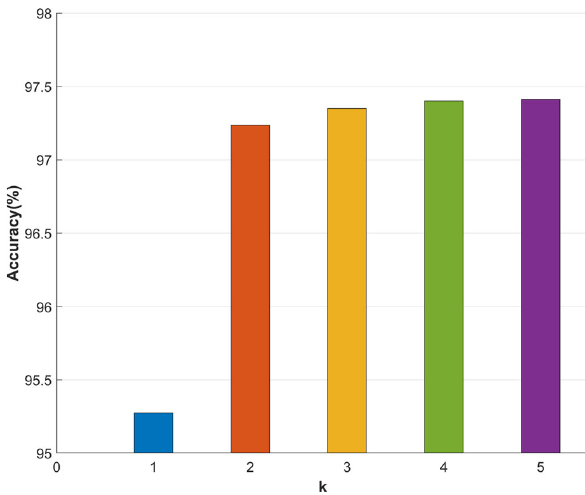
Fig. 7 The influence of the number of hidden layers on the generaliza- tion performance